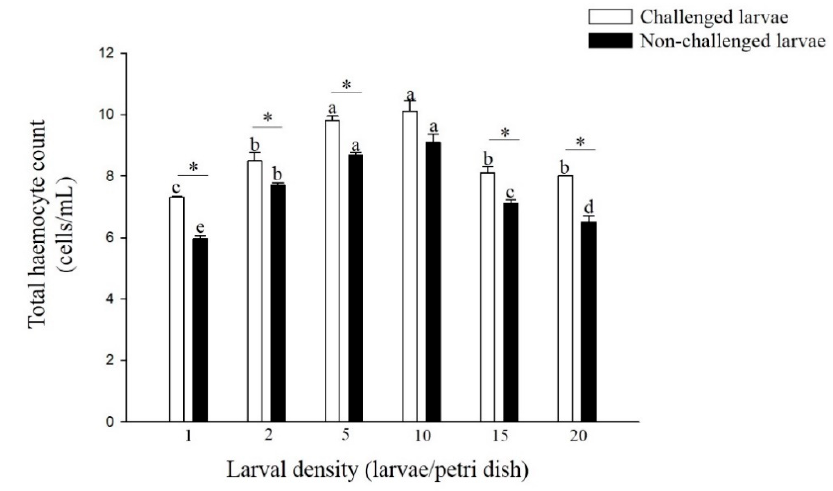
Figure 5. Total hemocyte counts of larvae P. xylostella reared at different larval densities. Bars of non-challenged (or challenged) larvae with the same letter are not significantly different at the 0.05 level by Tukey’s HSD multiple comparison. The asterisk indicates a significant difference at the 0.05 level by Student’s t -test between the non-challenged and challenged groups.